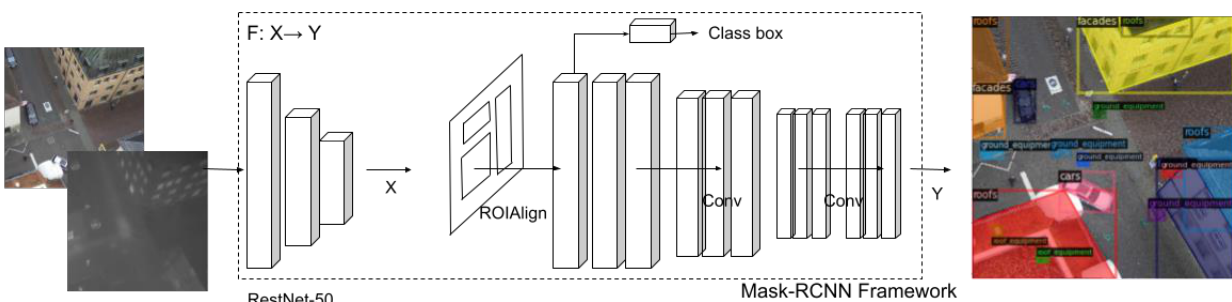
Figure 4. The fusion approach on Mask R-CNN.